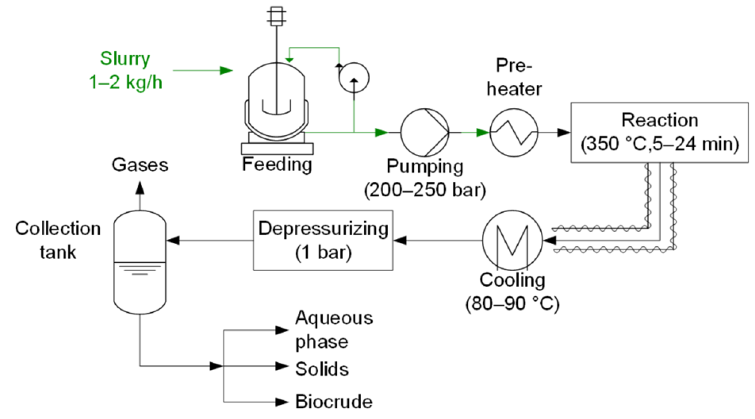
Figure 1. Simplified flow chart of RE-CORD HTL plant.